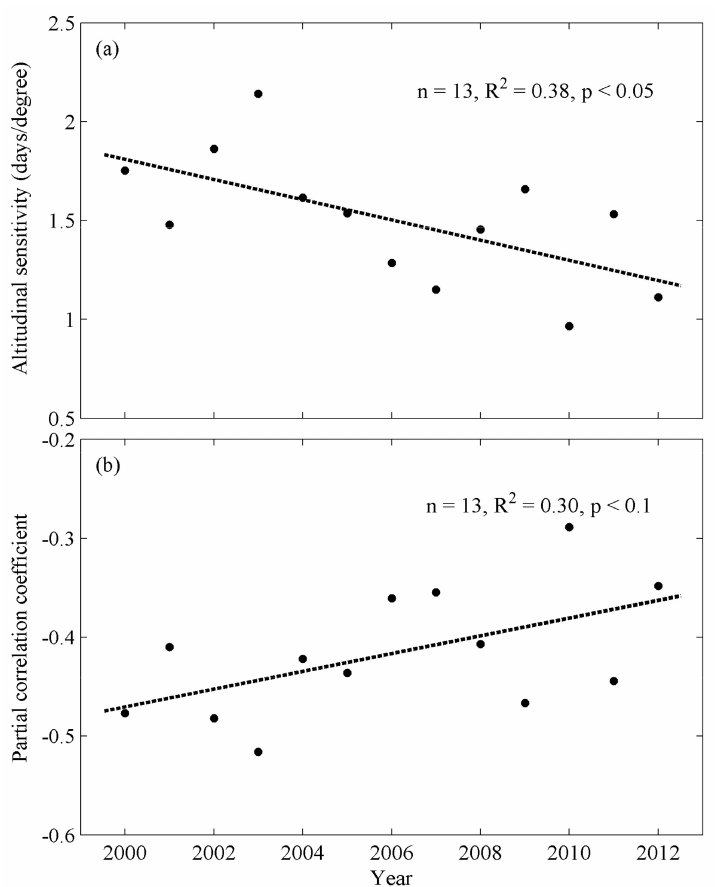
Figure 6. Linear trends of altitudinal sensitivity of the end date of the growing season (EOS) ( a ) and altitudinal e ff ect on EOS ( b ) from 2000 to